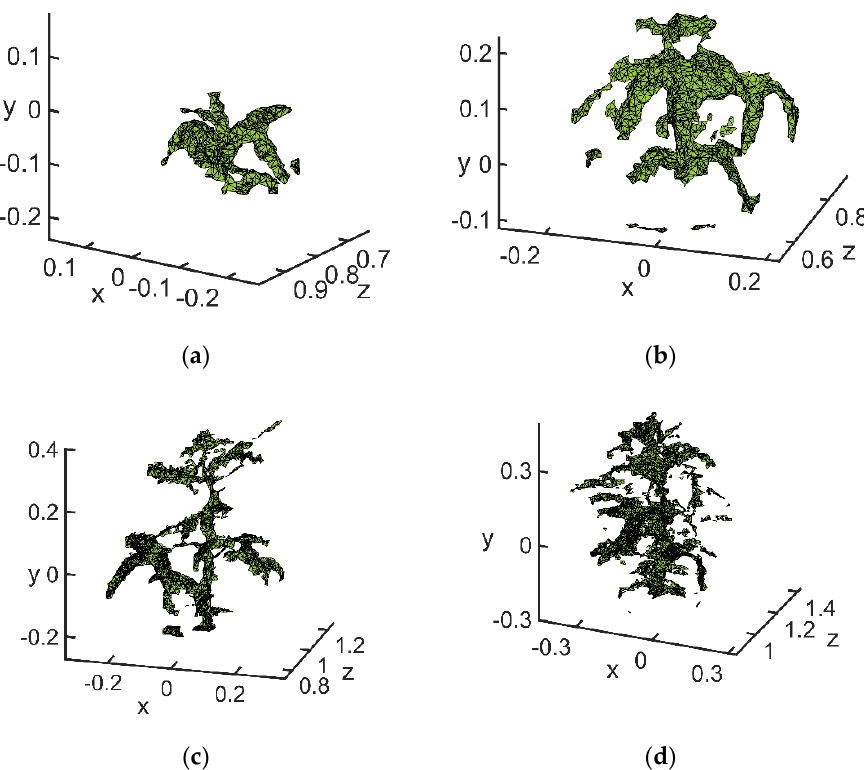
Figure 17. Edge extraction results: ( a ) flowering stage; ( b ) podding stage; ( c ) filling stage; ( d ) mature stage.